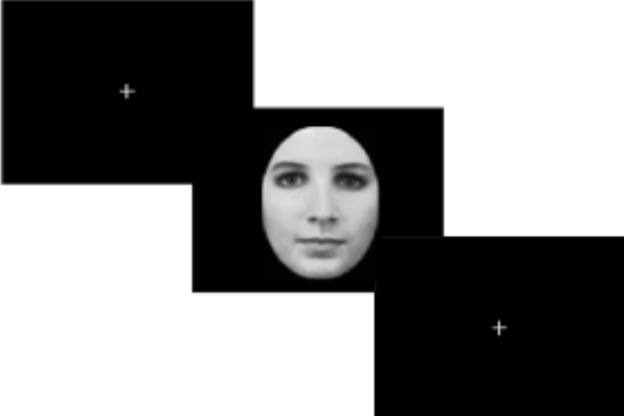
Figure 1. Task. Each trial started with a cross of fixation positioned in the center of the screen and was displayed for 3 s. Then, a face stimulus (50% male; 50% female) replaced it and was presented for 3 s. Participants had to observe the face displayed in the monitor and report its gender. At the end of each trial there was a fixation cross located in the center of the screen for 6 s (rest phase).